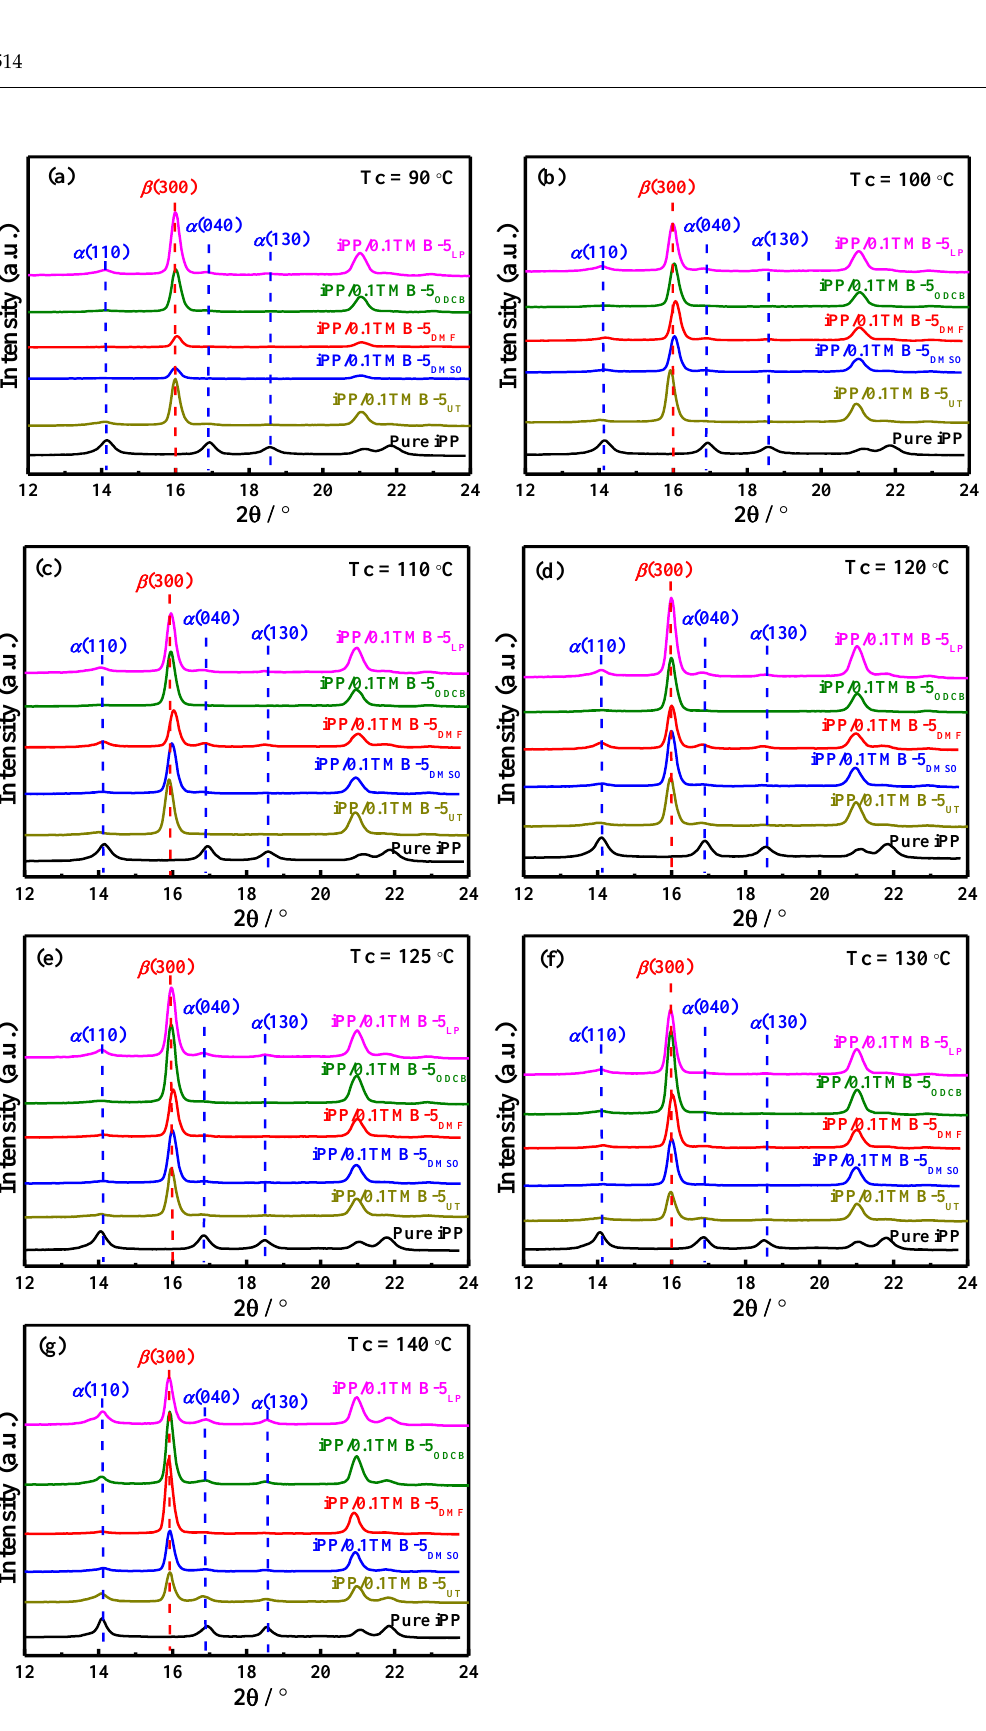
Figure 1. WAXD profiles of TMB-5 nucleated iPP (iPP/0.1TMB-5 UT , iPP/0.1TMB-5 DMSO , iPP/0.1TMB-5 DMF , iPP/0.1TMB-5 ODCB and iPP/0.1TMB-5 LP ) and pure iPP which have statically crystallized at different crystallization temperatures: ( a ) T c = 90 ̊ C, ( b ) T c = 100 ̊ C, ( c ) T c = 110 ̊ C, ( d ) T c = 120 ̊ C, ( e ) T c = 125 ̊ C, ( f ) T c = 130 ̊ C, ( g ) T c = 140 ̊ C, the NA content is 0.1 wt%. The calculated K β values of iPP/0.1TMB-5 UT , iPP/0.1TMB-5 DMSO , iPP/0.1TMB-5 DMF , iPP/0.1TMB-5 ODCB , and iPP/0.1TMB-5 LP crystallized at each individual crystallization tem-